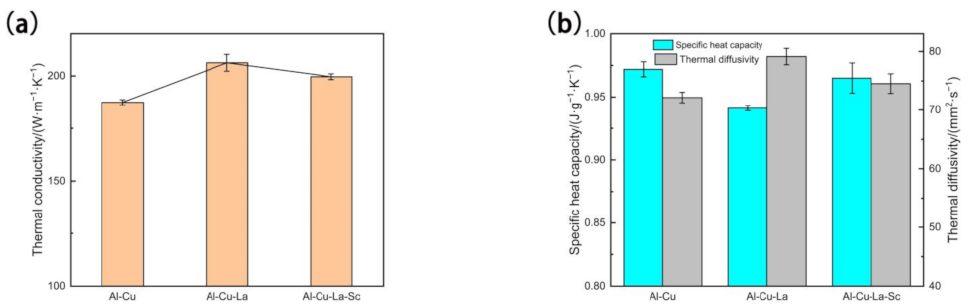
Figure 5. Properties of thermal conductivity of Al-Cu, Al-Cu-La, Al-Cu-La-Sc alloys: ( a ) Thermal conductivity, ( b ) Specific heat capacity and Thermal